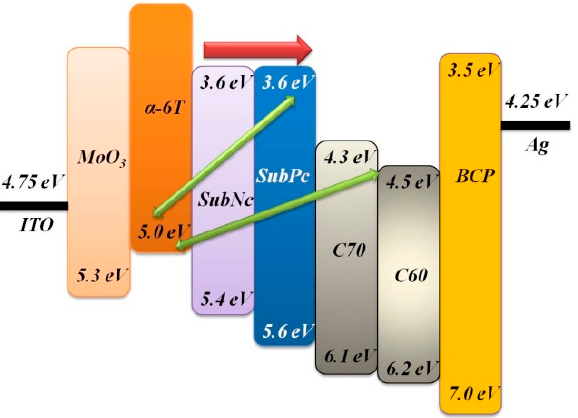
Figure 3. The energy levels diagram of used materials illustrating the charge transfer mechanism in this study.